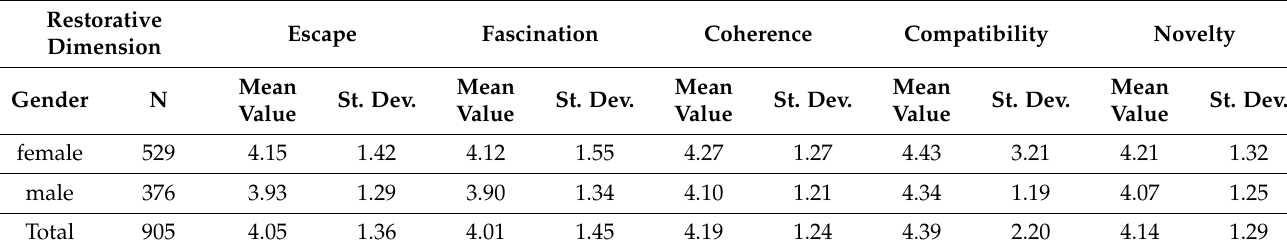
Table 5. Association between gender and restorative